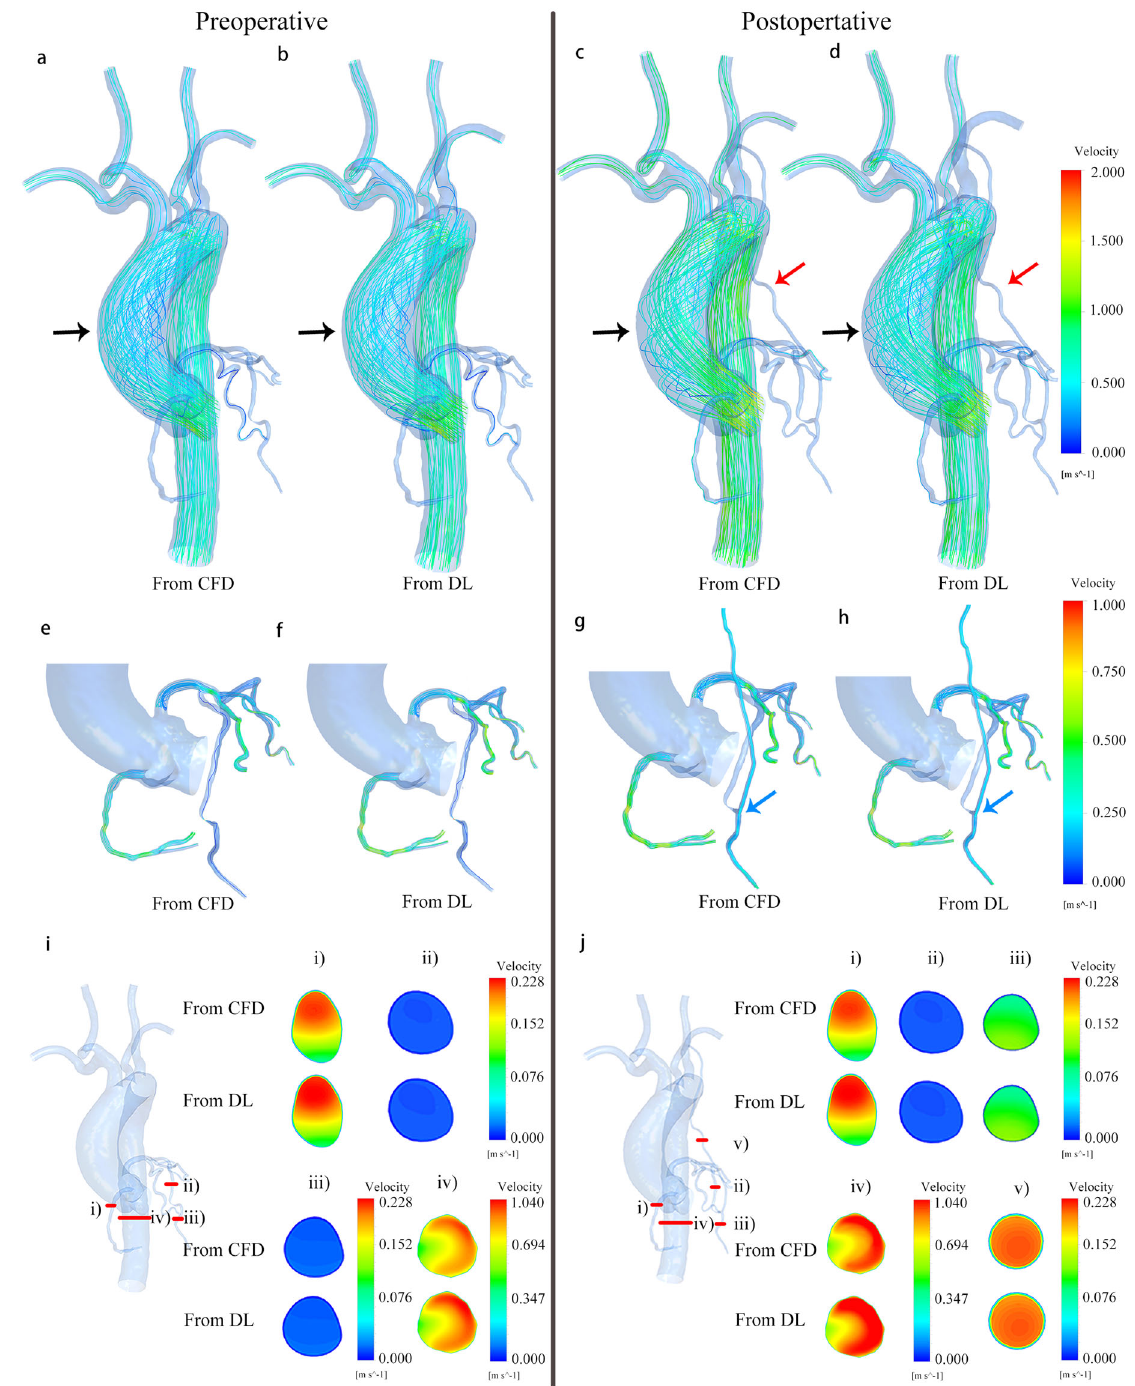
Fig. 1 Comparison of velocity fi elds from CFD and deep learning (DL) methods, using a sample with a stenosis rate of 85%. a – d Are streamline diagrams of the entire cardiovascular internal fl ow fi eld before and after CABG obtained from CFD and DL. The position indicated by the black arrow in a – d is the vortex region of ascending aorta. The position indicated by the red arrow in c , d is the grafts. e – h Are streamline diagrams of the coronary artery and grafts fl ow fi eld. The blood fl ow velocity inside the coronary artery is smaller than that in the aorta, which means that it is dif fi cult to clearly show the distribution of the internal fl ow fi eld in the coronary artery under the same velocity color bar. Therefore, the coronary fl ow fi eld is displayed separately. The position indicated by the blue arrow in g – h is the connection site between the graft and the LAD. i , j Are cross-sectional views of the velocity distribution, respectively from (i): RA branch; (ii): the proximal end of LAD before stenosis; (iii): the distal end of LAD after stenosis; (iv): descending aorta; (v): graft. (v) can re fl ect laminar fl ow in the graft. The comparison results con fi rm the high consistency of the velocity fi eld obtained by the two methods. This clearly shows the effect of CABG surgery on the fl ow fi eld distribution of the entire cardiovascular